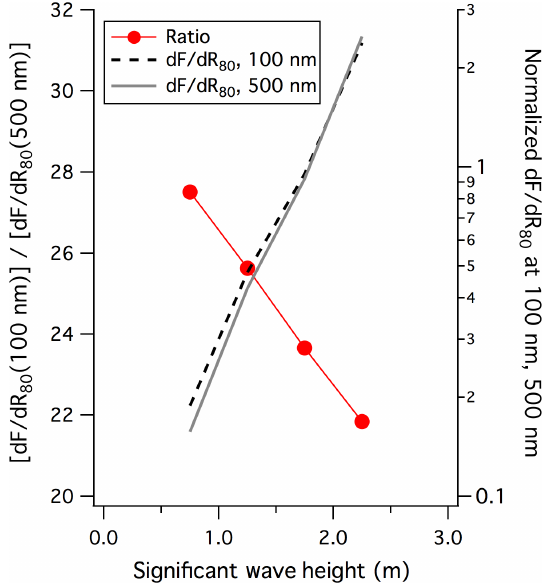
Figure 12. Ratio of size-distributed source number flux in film drop mode (here R 80 = 100nm) to that in the jet drop mode (here R 80 = 500nm) as well as normalized d F/ d R 80 at these sizes as a function of significant wave